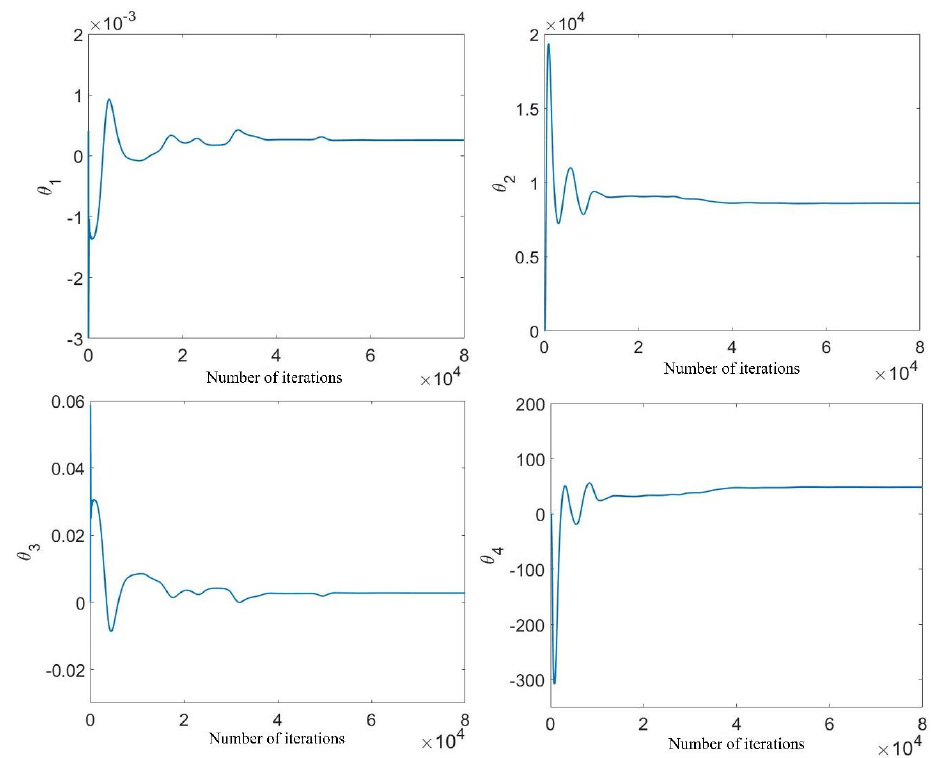
Figure 8. The results of parameter identification. Table 2. The results of parameter identification and true values.